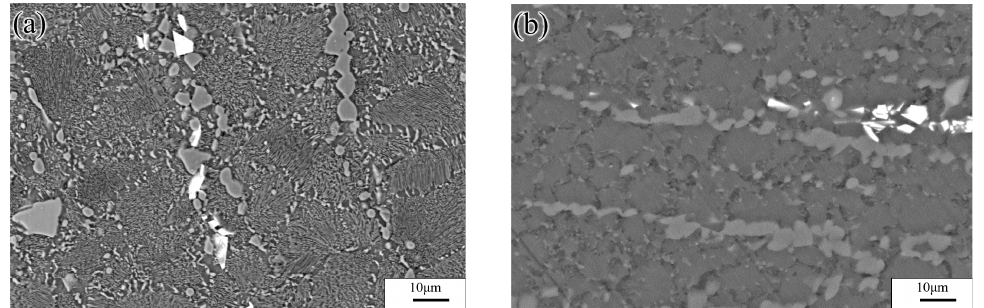
Figure 4. SEM images of experimental alloy deformed under different conditions: ( a ) 523 K/0.0001 s − 1 and ( b ) 673 K/0.1 s − 1 .